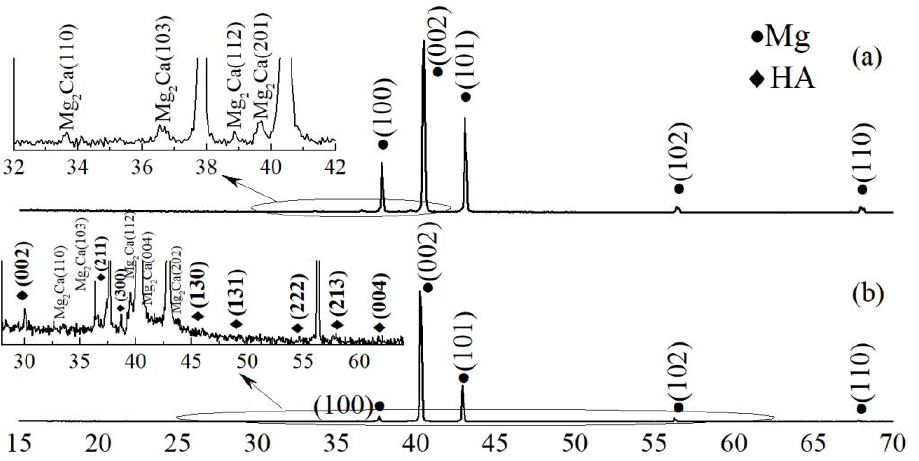
Figure 1. X-ray profiles of as-deposited Cu-hydroxyapatites (HA) coating on Mg0.8Ca ( a ) and Cu-HA coating on Mg0.8Ca after heat treatment (HT) at 450 °C for 3 h ( b ).